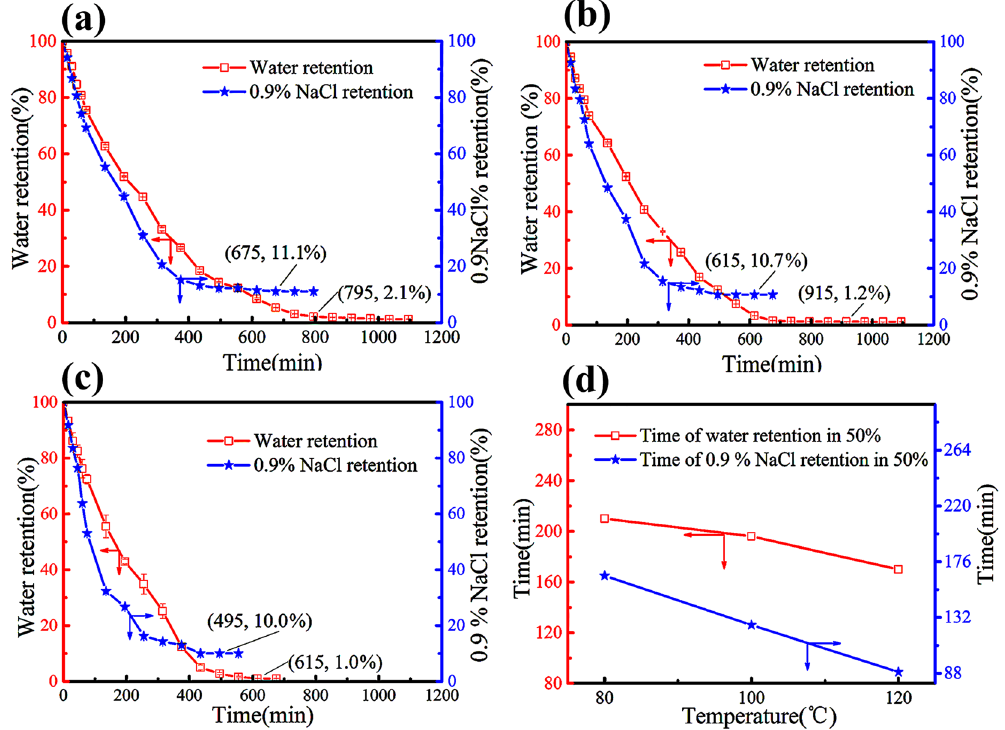
Figure 4. The hydrogel water retention behavior at ( a ) 80 °C, ( b ) 100 °C, and ( c ) 120 °C (Data were given as means (n = 3)). ( d ) Time of water retention in 50% at 3 different